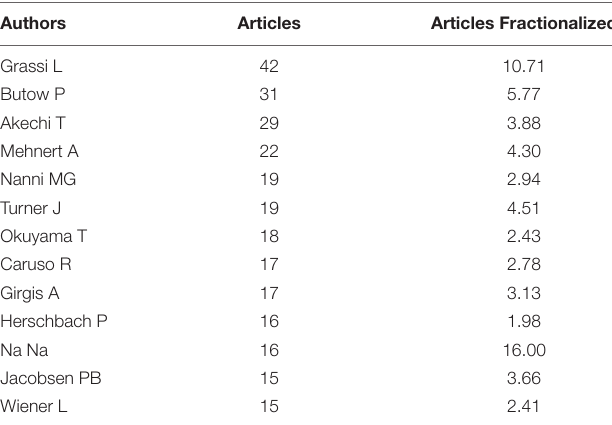
TABLE 3 | Most relevant authors with at least 15 publications.